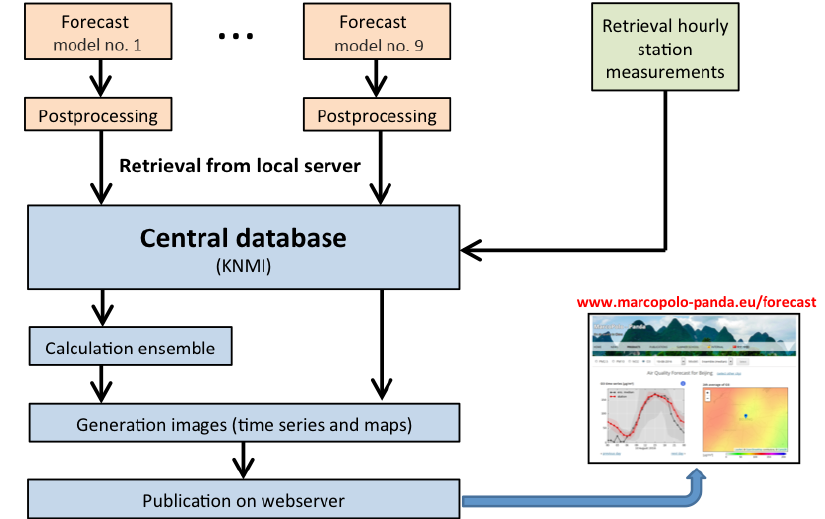
Figure 2. Structure of the operational multi-model forecast system with the nine model components. Postprocessed forecasts for the next 3 days provided by each model are sent to a central database maintained by the Royal Netherlands Meteorological Institute (KNMI). Ensem- ble medians and means are calculated and information (predicted daily variations in surface concentrations for 37 major Chinese cities, and maps of predicted diurnal mean surface concentrations) and are posted on http://www.marcopolo-panda.eu/forecast (last access: 7 Decem- ber 2018). Users in China are redirected to the mirror website maintained by SMS (http://116.62.195.108/, last access: 7 December 2018). The forecasts are compared with the median and mean observations provided by monitoring stations at different locations of the 37